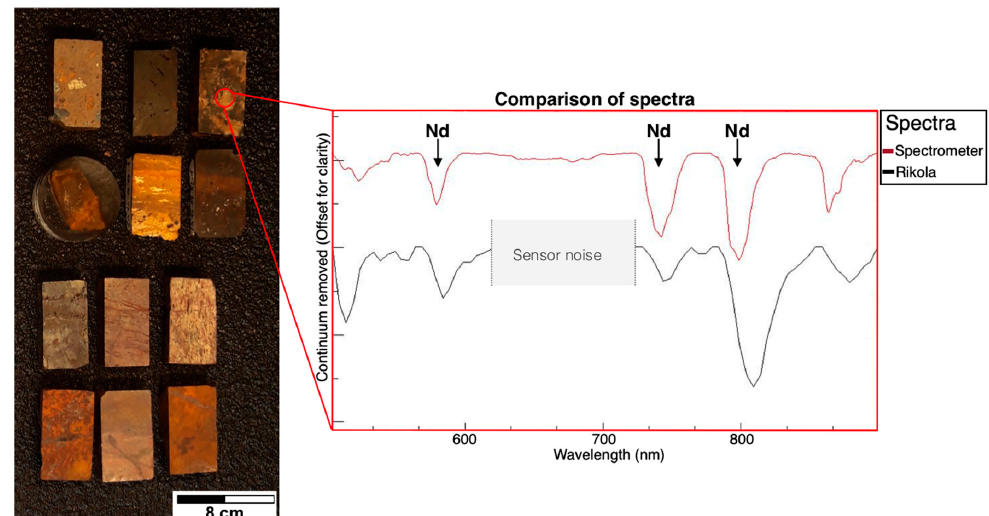
Figure A1. Spectrum taken from a Rikola image of rock samples from the field, compared with spectrum taken of the same sample with the spectrometer. Nd absorption features can be seen in both spectra at the same wavelengths.